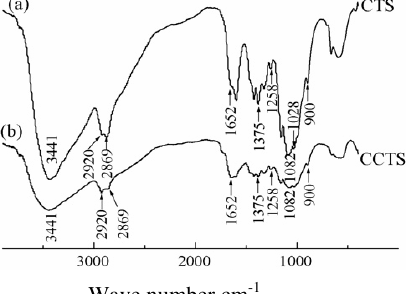
Figure 6. FT-IR spectra (a) Chitosan (labelled as CTS) and (b) epichlorohydrine cross-linked chitosan (labelled as CCTS), using KBr pellets. The range from 4000 to 400 cm -1 was